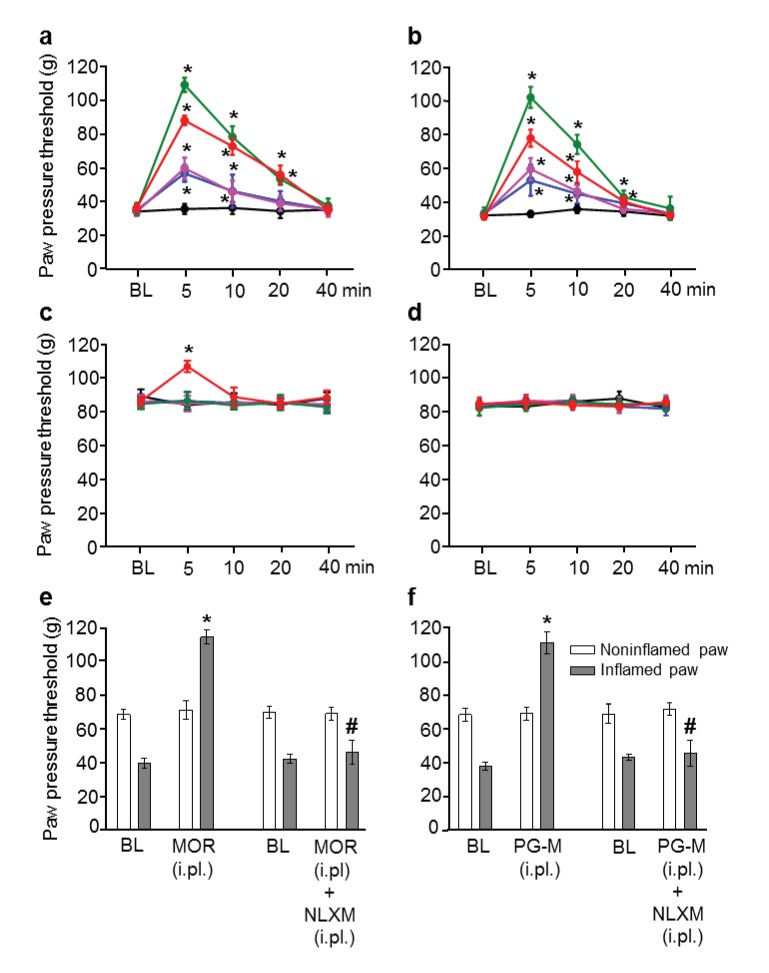
Analgesic effects after intraplantar (i.pl.) injection of morphine or PG-M in rats with unilateral hindpaw inflammation.Effects on mechanical pain thresholds (PPT) in inflamed (a, b) and noninflamed (c, d) hindpaws following unilateral i.pl. injections of morphine (MOR; a, c, e) or PG-M (b, d, f) into the inflamed paw. Dosages of MOR and PG-M represent the absolute amounts of morphine-free base (see Table 1). Unilateral i.pl. injection of NLXM (50 μg/paw) completely reversed peak PPT elevations occurring at 5 min after i.pl. morphine (100 μg; e) or i.pl. PG-M (equivalent to 100 μg morphine; f). BL: baseline PPT before injections. (a, b, c) *p<0.05, two-way RM-ANOVA and Bonferroni test (compared to controls). (e, f) *p<0.05, paired t-test (BL vs. agonist); #p<0.05, unpaired t-test (agonist vs. agonist + NLXM). N = 8 rats per group; means ± SEM. PPT increases in a and b (0–100 μg) were dose-dependent (p<0.05, linear regression ANOVA).DOI:
http://dx.doi.org/10.7554/eLife.27081.00810.7554/eLife.27081.009Figure 6—source data 1.Raw data for Figure 6.